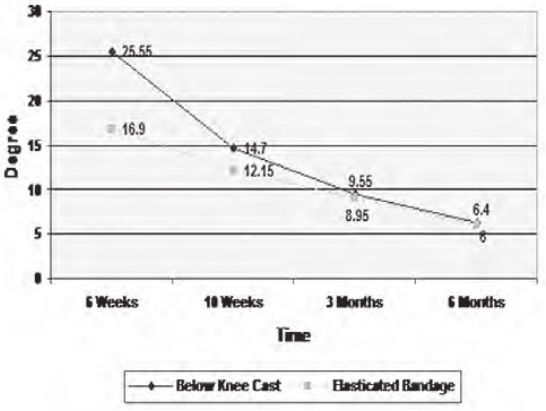
Figure 3: Total Loss of Range of Motion (cid:55)(cid:75)(cid:72)(cid:3) (cid:86)(cid:90)(cid:72)(cid:79)(cid:79)(cid:76)(cid:81)(cid:74)(cid:3) (cid:82)(cid:73)(cid:3) (cid:87)(cid:75)(cid:72)(cid:3) (cid:68)(cid:81)(cid:78)(cid:79)(cid:72)(cid:3) (cid:76)(cid:81)(cid:3) (cid:42)(cid:85)(cid:82)(cid:88)(cid:83)(cid:3) (cid:37)(cid:3) (cid:90)(cid:68)(cid:86)(cid:3) (cid:86)(cid:76)(cid:74)(cid:81)(cid:76)(cid:191)(cid:70)(cid:68)(cid:81)(cid:87)(cid:3) improved due to early range of motion of the ankle